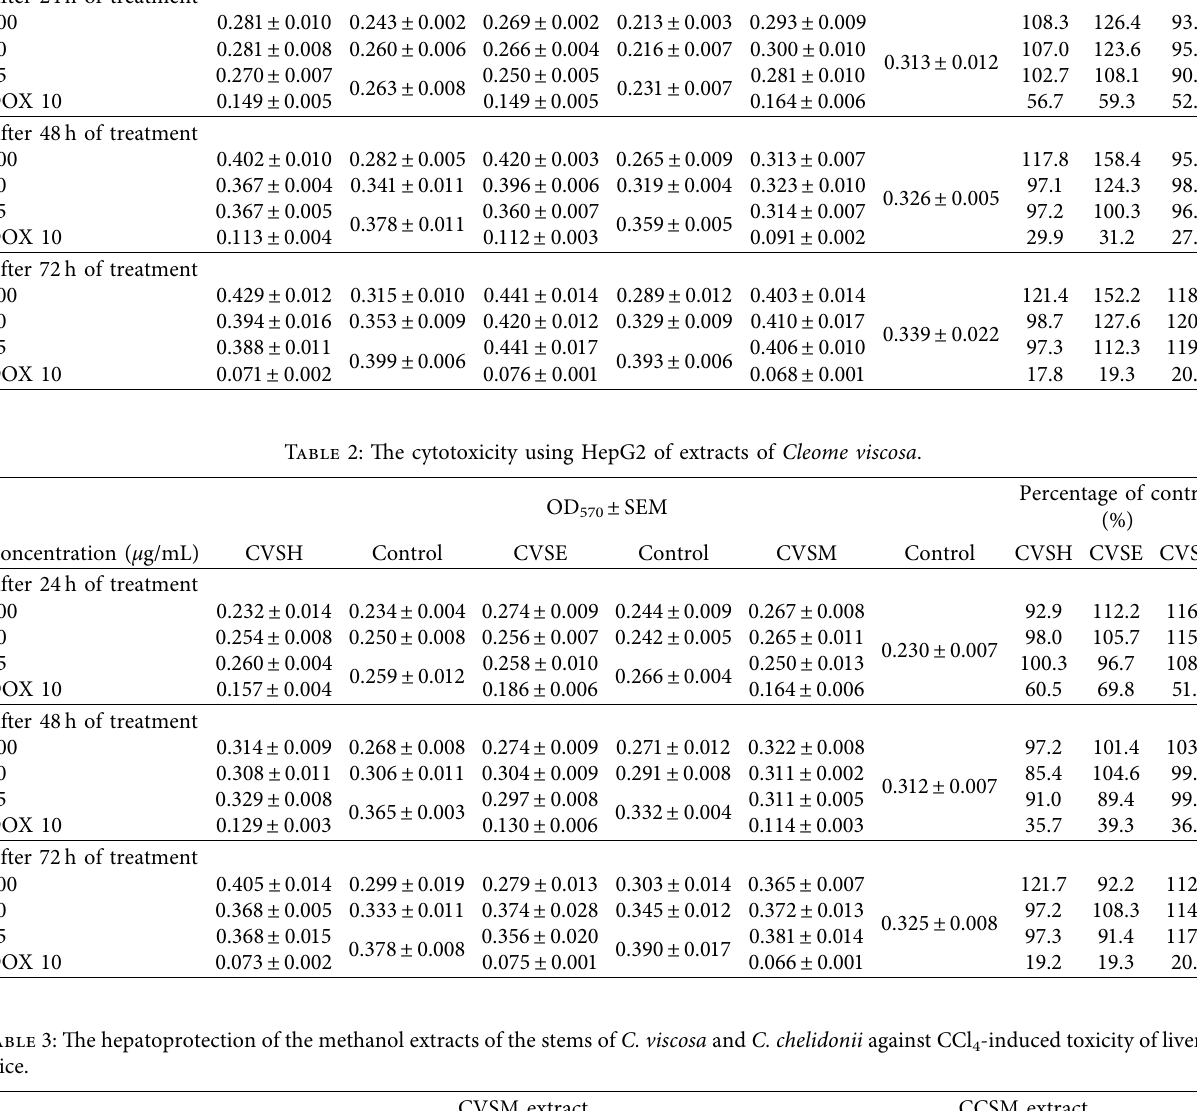
Table 1: The cytotoxicity using HepG2 of extracts of Cleome chelidonii. OD 570 ± SEM